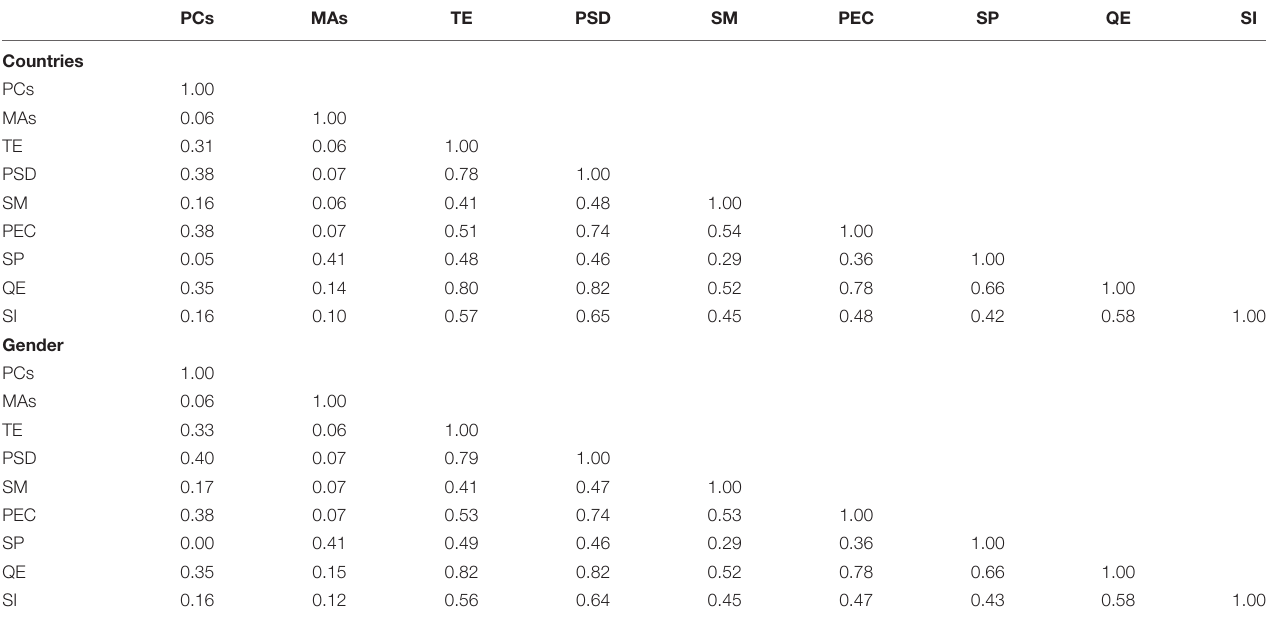
Refer to Table 2 for abbreviations.